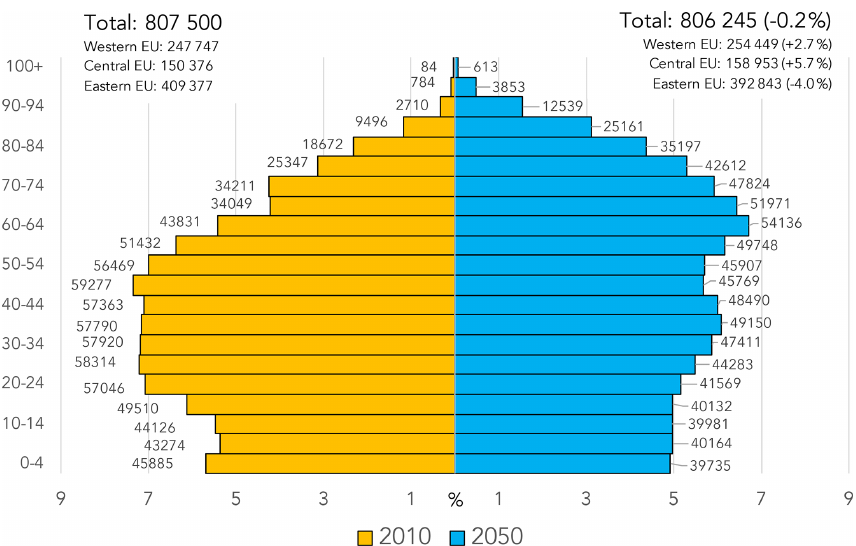
Figure 1. Population pyramids by age range for the years 2010 (orange, left) and 2050, as projected by the UN (blue, right). Population data are shown in thousands. The x axis represents the percentage of the contribution of each age range to the total population.